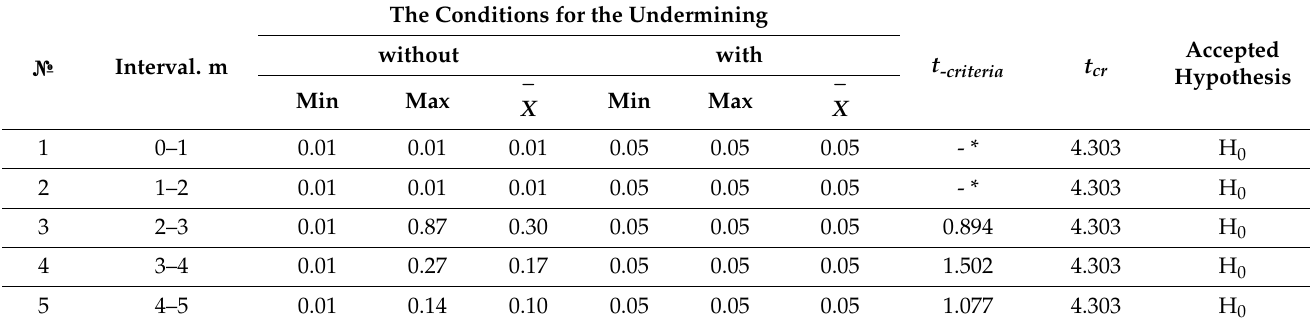
Table 6. The results of the statistical analysis of the experimental studies of the free gas pressure of the drift